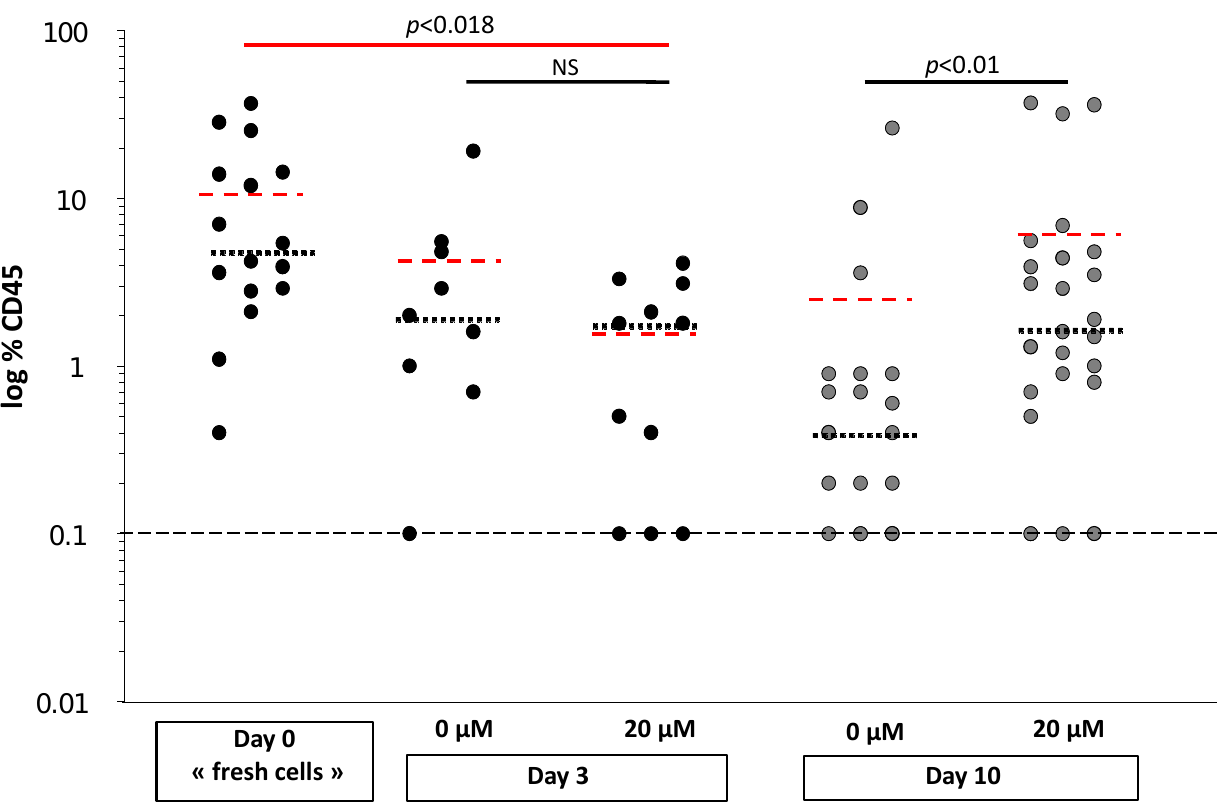
Figure 3. αTOA preserves a fraction of the primitive repopulating cells in culture, n = 3. Results were acquired in 3 independent experiments from 3 different CB units. The mice were injected with the cells on day 0 (1000 cells) and day 3 of primary culture with a cell dose representing the progeny of 1000 day 0 cells (black points: ~3 to 4 × 10 3 cells at day 3). On day 10 of the secondary culture, a 1/10 equivalent number of day 0 cells (i.e., day 3 progeny of 1000 day 0 cells) was injected (grey points: ~64 to 82 × 10 3 cells). In these experiments, a dose of 20 µM αTOA was applied, which was confirmed to be physiologically relevant and active. The Mann–Whitney test (black lines) showed significant results for day 10 of the secondary culture. The Kruskal–Wallis test (red line) for multiple comparisons, followed by the Mann–Whitney test with Bonferroni correction, showed significant results for day 3 with 20 µM αTOA compared to day 0. Means are represented in black dotted lines and medians in red dotted lines.